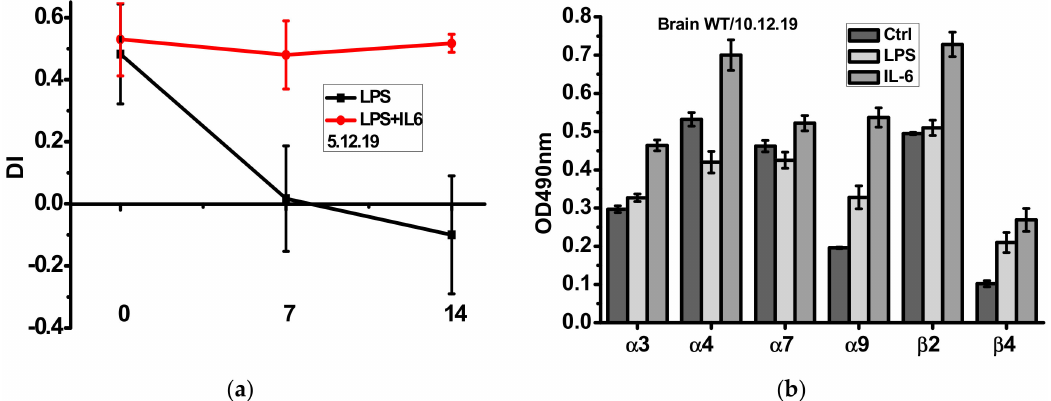
Figure 3. Episodic memory (discrimination index studied in NOR test) ( a ) and nAChR subunit composition in the brain (w / o mitochondria, ( b ) of the wild-type mice injected with either LPS alone or LPS and IL-6. Ctrl–non-injected mice. ** p < 0.005; *** p < 0.0005 compared to LPS-treated mice, n =